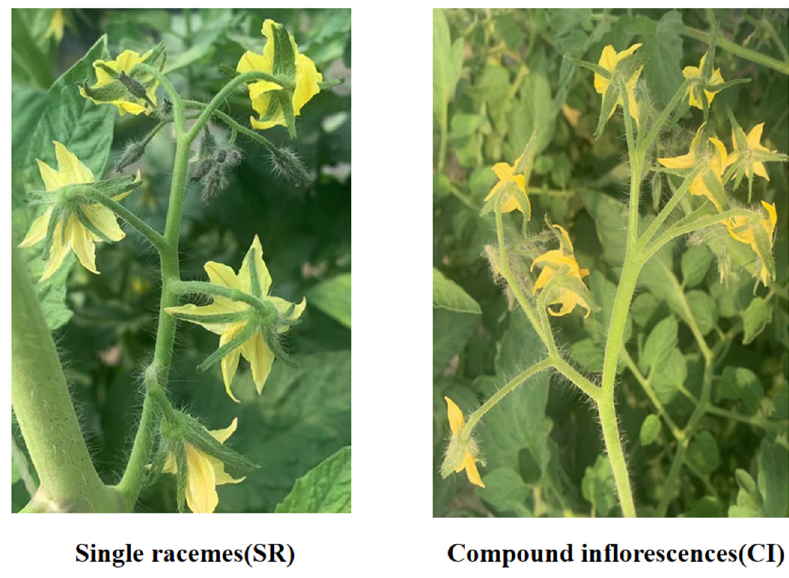
Figure 9. Appearance of the parental materials used for transcriptome analysis. SR was used as the male parent, and CI was used as the female parent.